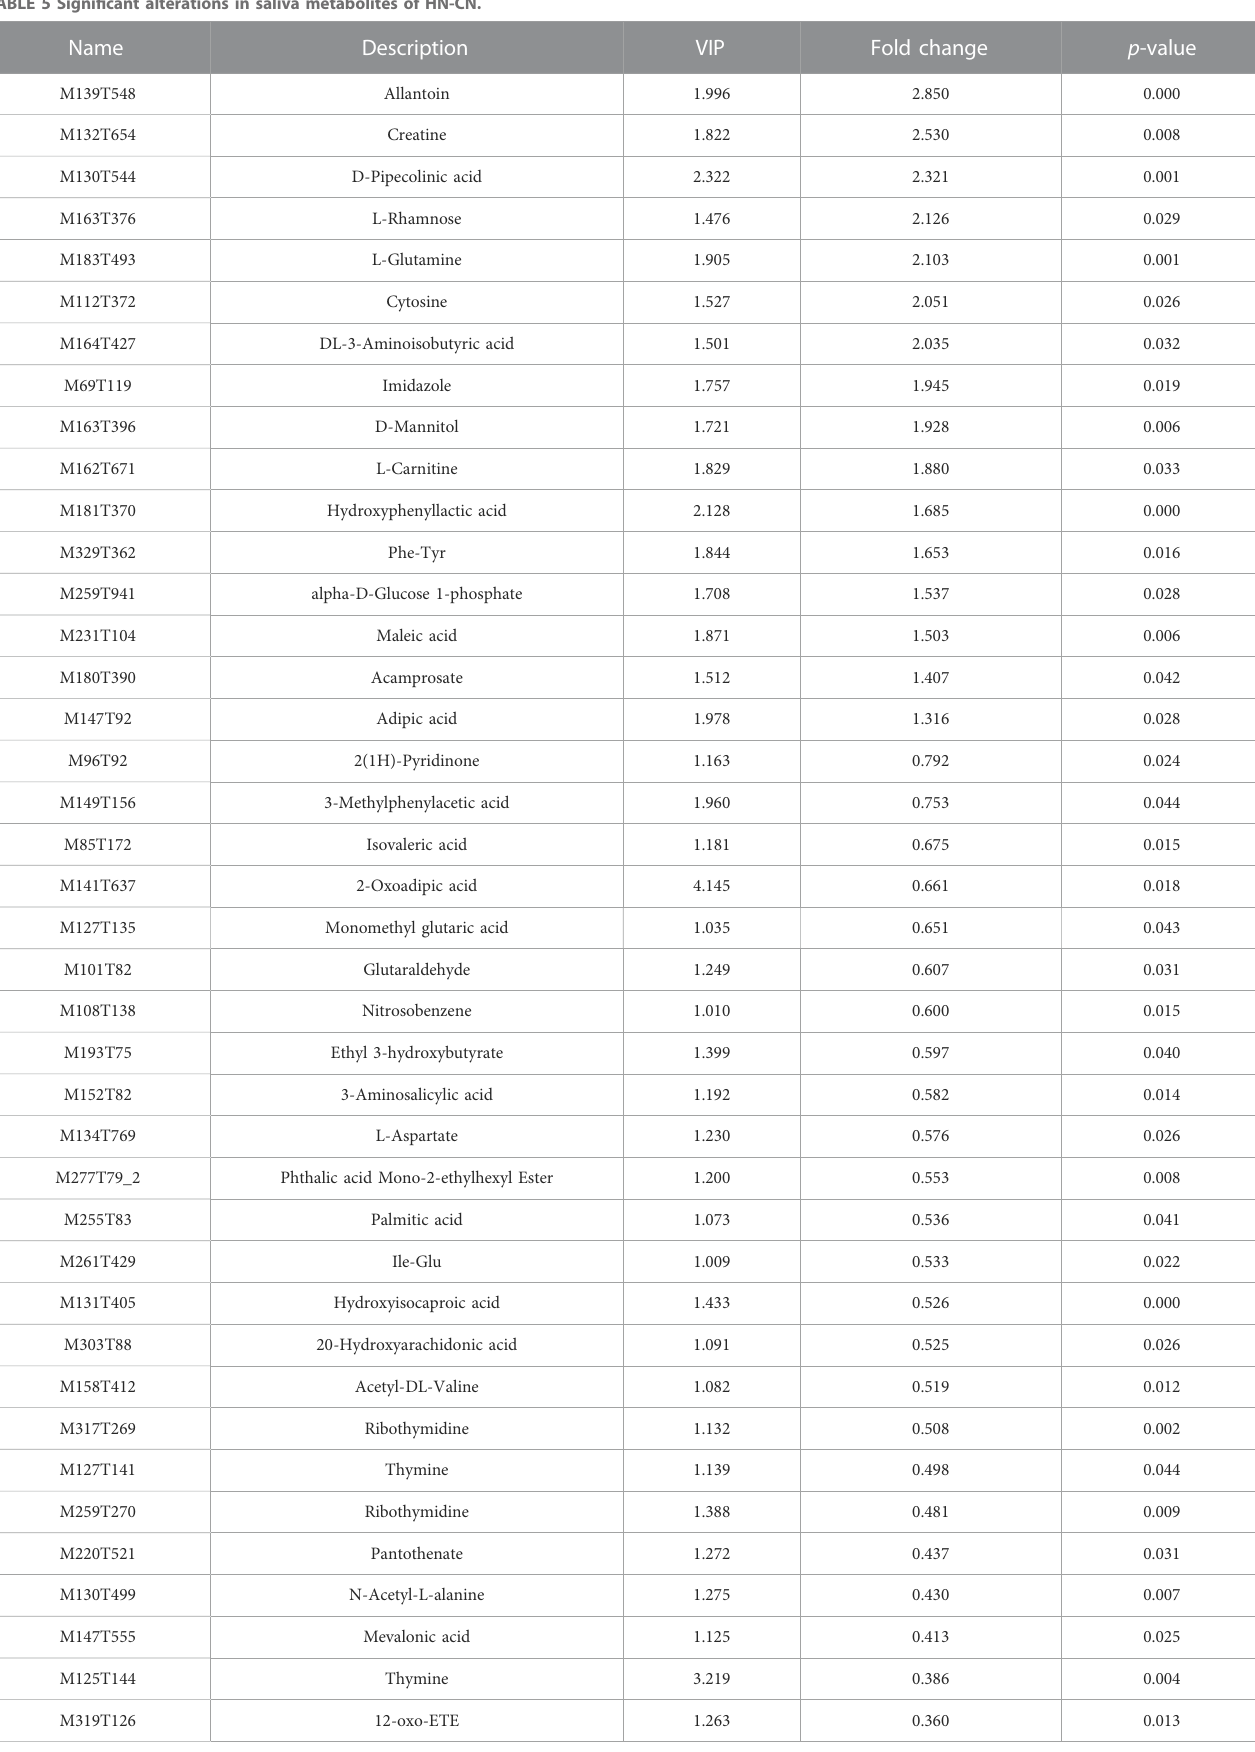
TABLE 5 Signi fi cant alterations in saliva metabolites of